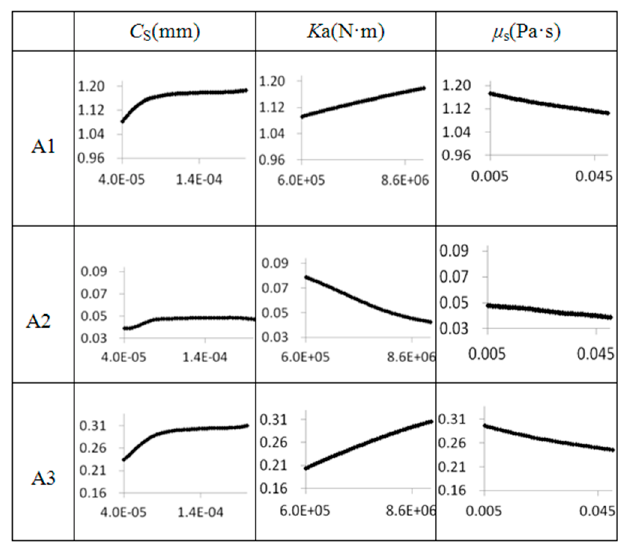
Figure 16. Effect of SFD design parameters on the amplitude of the fundamental, 2× fundamental and 3× fundamental frequency of the system with the misalignment-rubbing coupling fault.